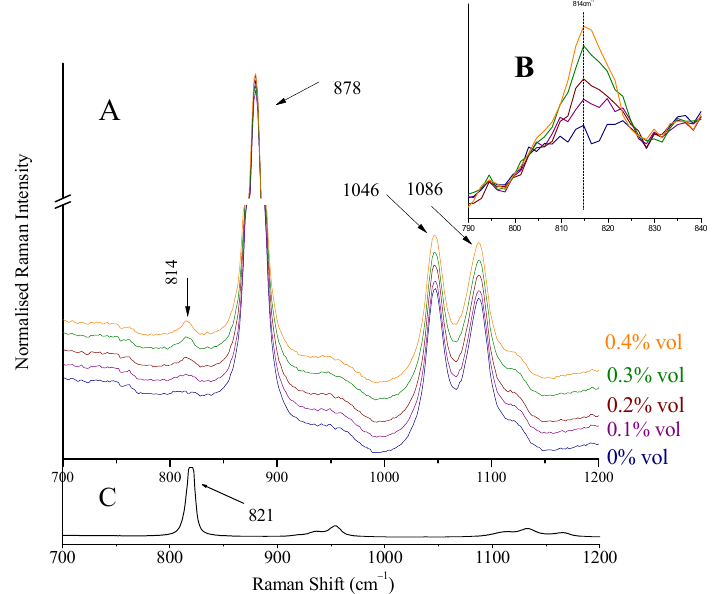
Figure 8. ( A ) Raman spectra of increasing concentrations of methanol (0–1.00% vol) added to Bal- lantine’s whiskey. The peak of methanol appears as a shoulder on the left of the ethanol peak at 1046 cm −1 . The spectra quoted are normalized to the 1046 cm −1 . ( B ) The magnified spectral area, 1000–1030 cm −1 , of ( A ). Methanol presence can be verified for a content of 0.40% vol or higher. ( C ) Raman spectrum of methanol–water solution (1:1).